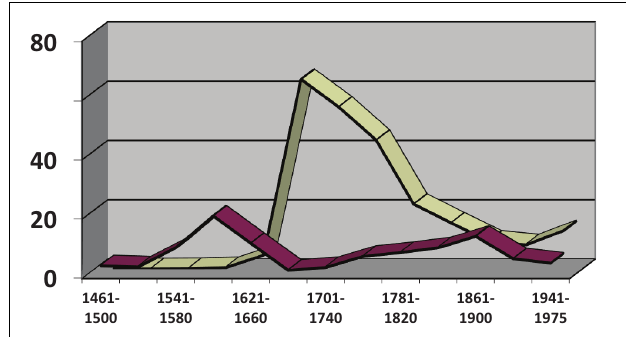
FIGURE 8 | Weighted frequency curves showing the constructions ART + Wh ( me explicó el cómo lo hacían , “he explained ART how it was done”: lower curve) and ART + C ( te agradezco el que vengas , “I am grateful to you ART that you came”: curve with peak frequency in 18th Century). Data from CORDE.